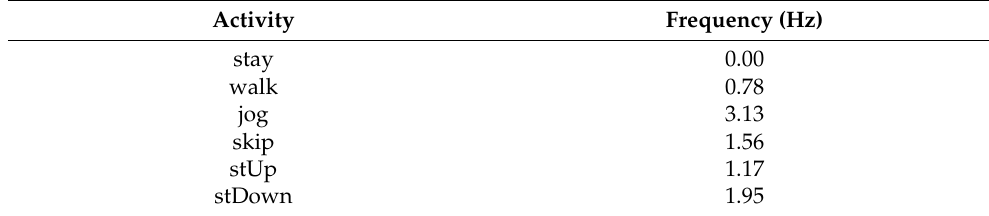
Table 1. Important frequency of each activity in HASC.